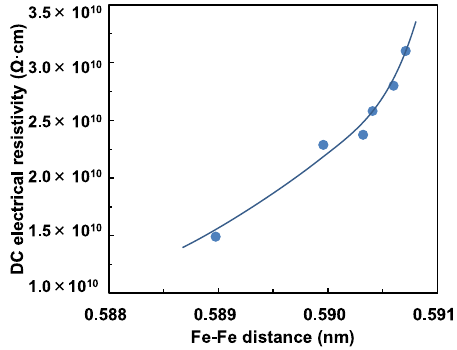
Figure 4. Dependence of DC electrical resistivity on Fe ‐ Fe distance for 20Fe y BiB glasses.